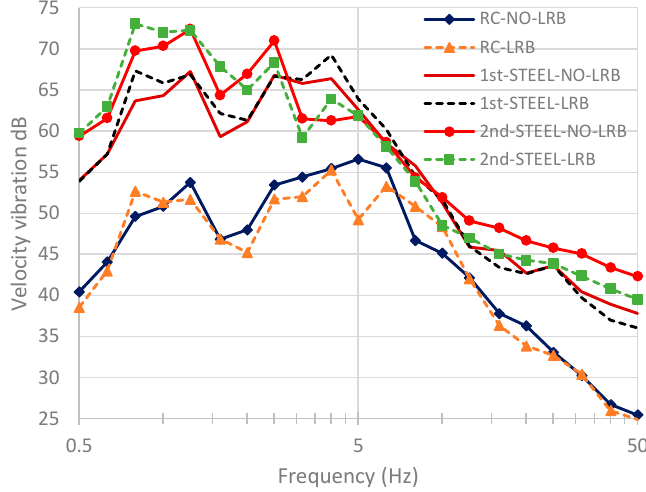
Figure 14. Velocity vibration dB changing with frequencies at the first to third floors under the wind load with the average speed of 25 m / s for the factory with or without LRBs (The dB values with LRBs due to α from 0.01 to 0.07 are almost identical.).